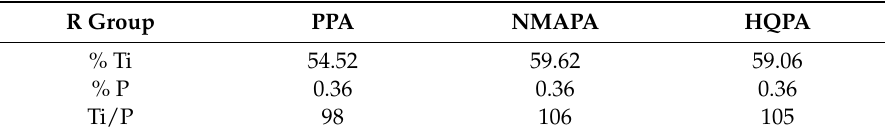
Table 3. Ti and P elemental analysis of hybrid samples (TiO 2 ) 100 (O 3